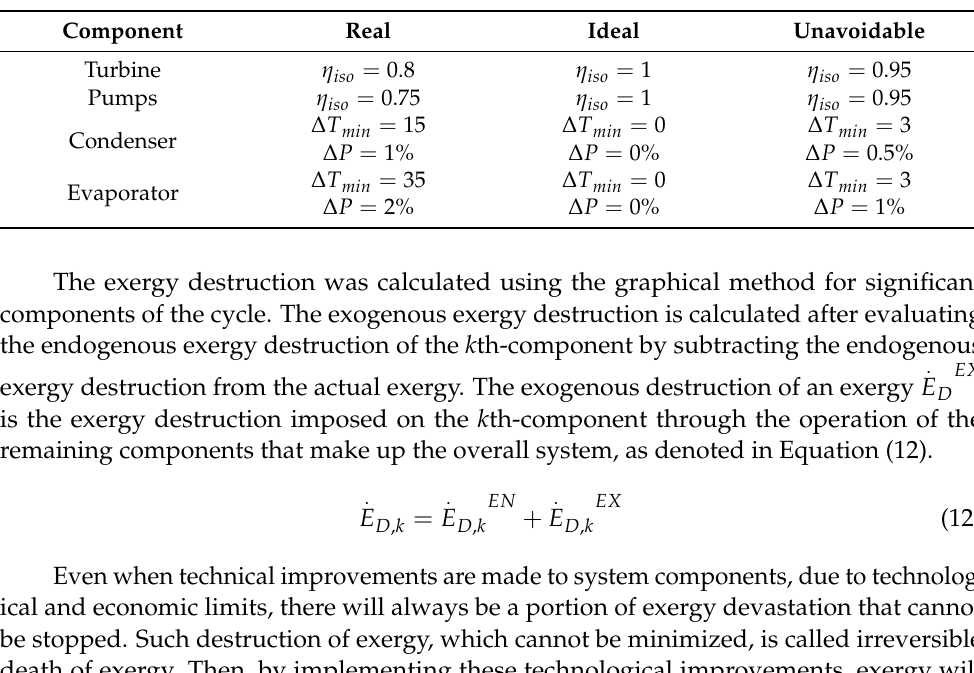
Table 4. Real, ideal, and unavoidable conditions for the ORC cycle. Adapted from